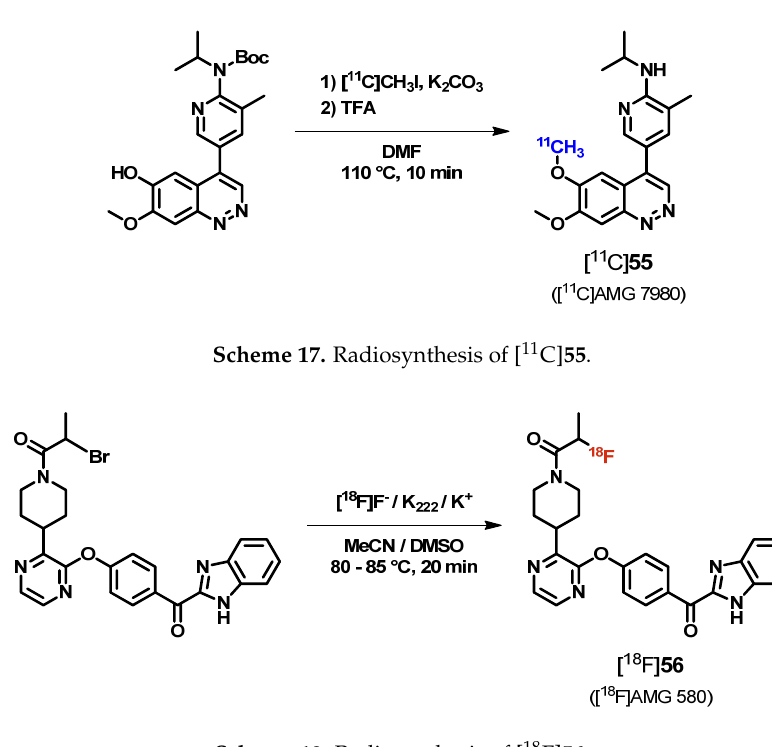
Scheme 18. Radiosynthesis of [ 18 F] 56